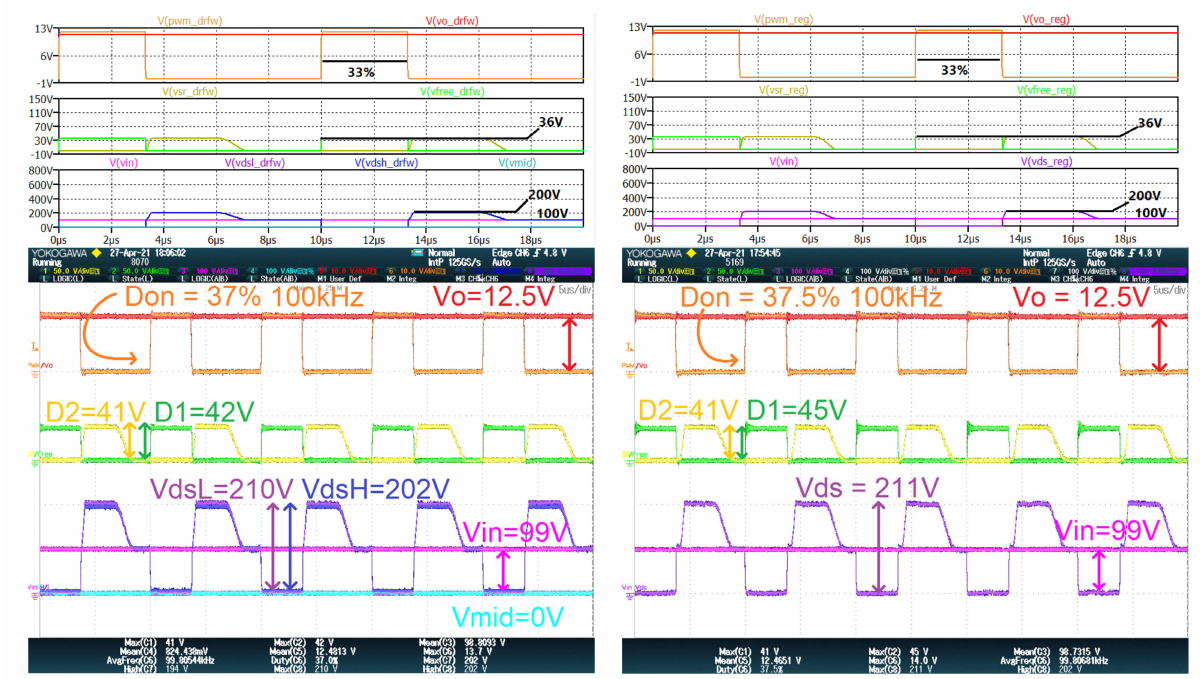
Figure 13. Low line minimum voltage (90 V) DVFW simulation ( top left ) and measure- ment ( bottom left ) vs. conventional forward converter simulation ( top right ) and measurement ( bottom right